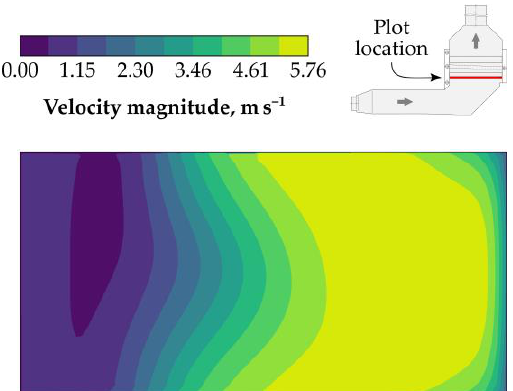
Figure 11. Contour plot of velocity magnitude just below the bottom bundle, which was obtained using the CFD model from Table 5. The velocity distribution was not uniform (due to the flue gas duct being bent) and fluctuated in time.